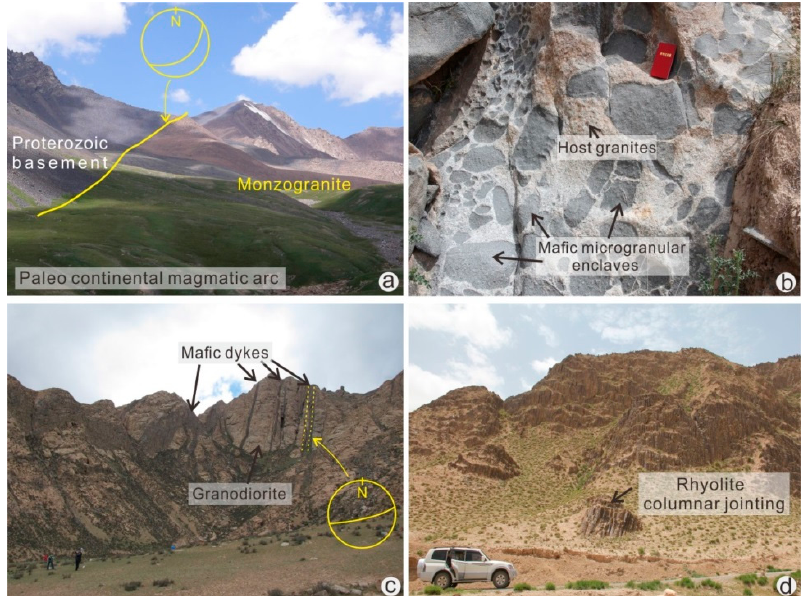
Figure 10. ( a ) Monzogranites intruding the Proterozoic basements (biotite quartz schist), ( b ) Early Triassic host granites and dark microgranular enclaves showing evidence for magma mixing, ( c ) Late Permian dyke swarm intruded into nearly coeval magmatic arc (granodiorite) rocks, and ( d ) Late Triassic post-collisional rhyolite exhibiting columnar jointing.